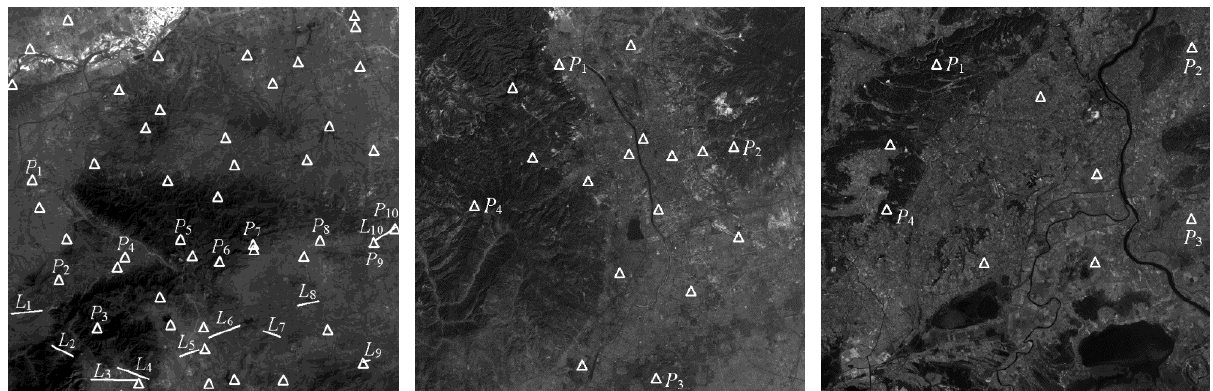
Table 1. General characteristics of the ZY-3 datasets.